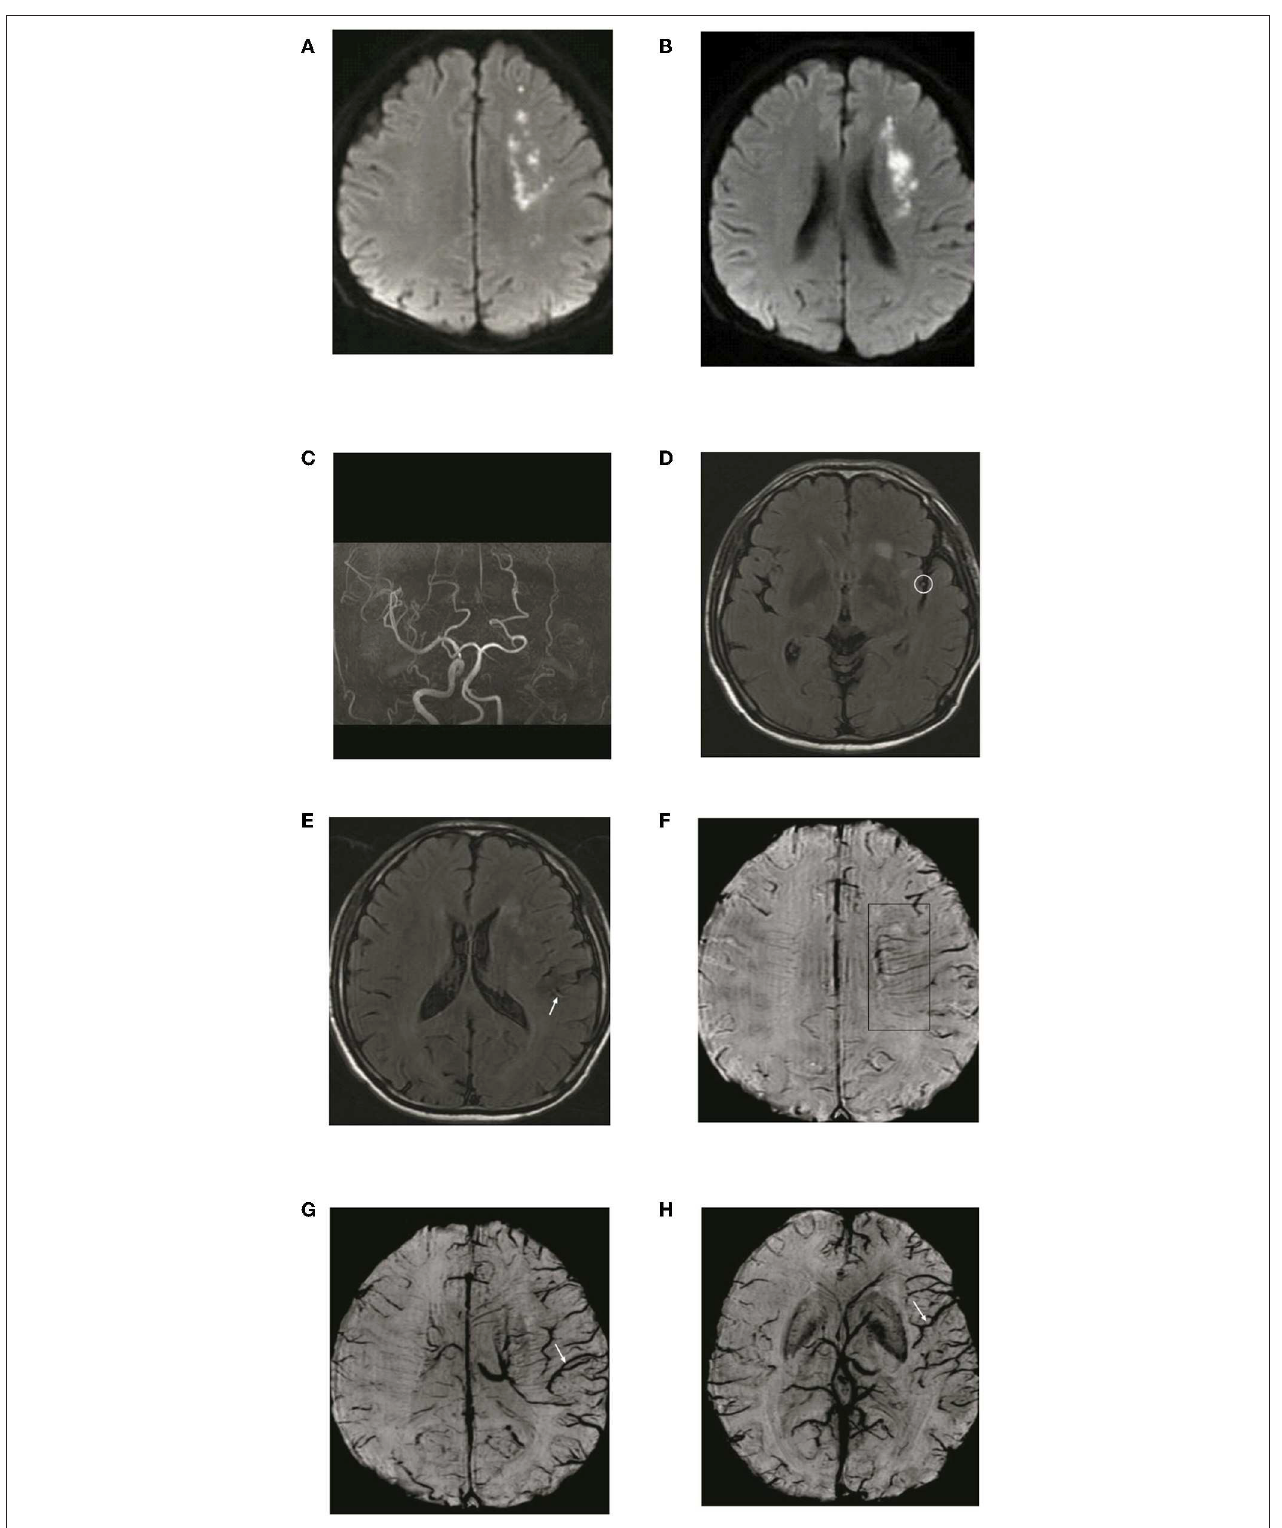
FIGURE 5 | Typical patient with asymmetric deep medullary veins (ADMV). A 70-year-old male presented with right limb weakness for 6h. (A,B) The left frontal lobe shows acute corona radiata cerebral infarction on DWI; (C) Occlusion of the left internal carotid artery on magnetic resonance angiography with maximal intensity projection; (D,E) HVS with a score of 2 on T2-FLAIR image: (F) Presence of ADMV; (G,H) ACV with a score of 6 on SWI.